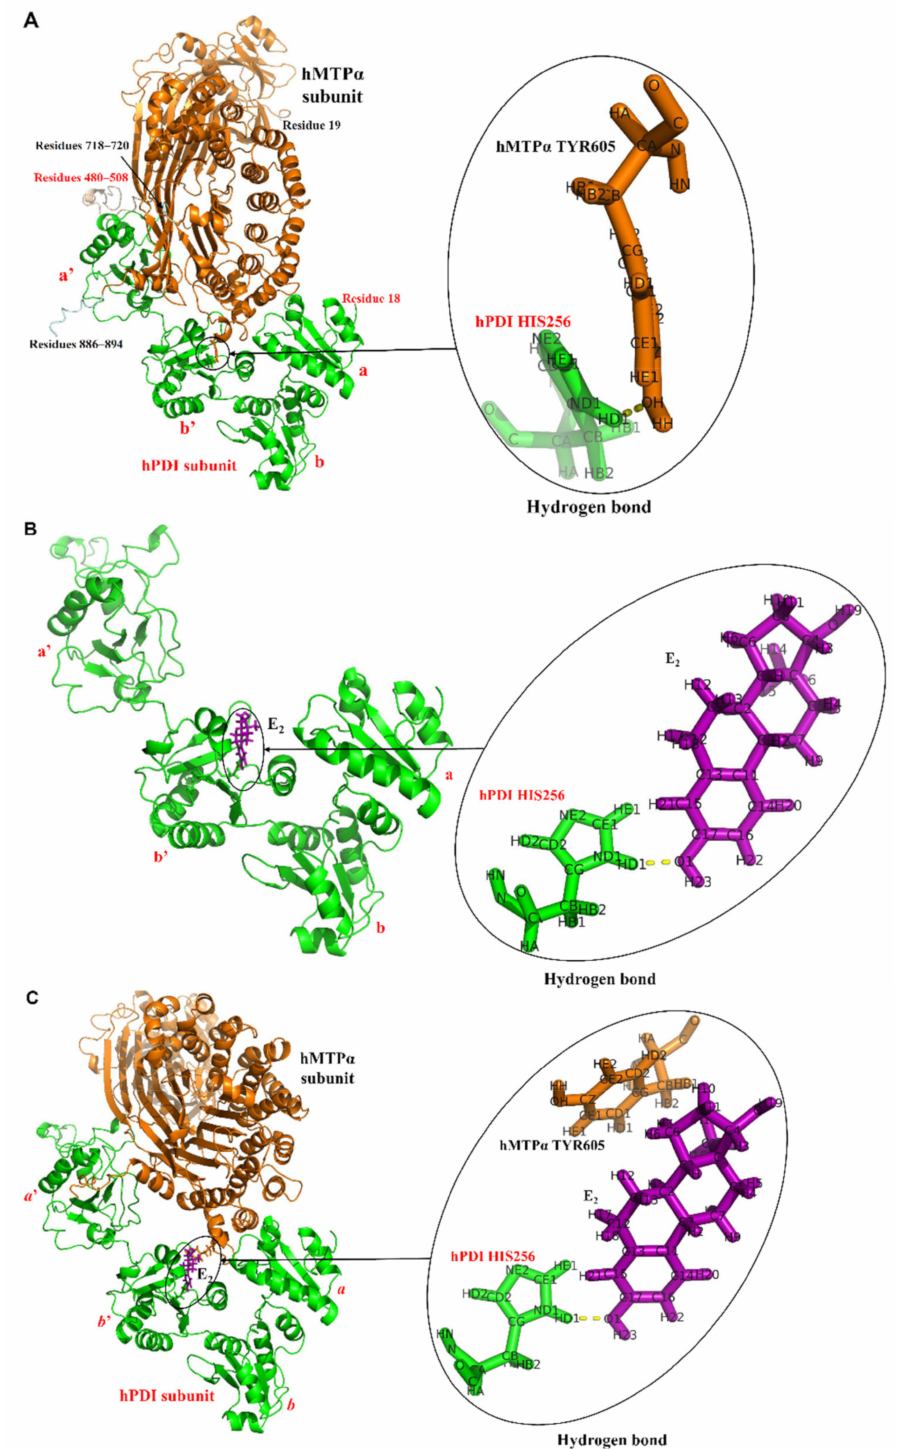
Figure 1. Complete structures of hMTP, hPDI–E 2 and hMTP–E 2 complexes. ( A ) Complete structure of the hMTP complex by adding the missing residues of hMTP α subunit (13 residues) and hPDI (30 residues) back in their experimentally determined structures. There is a hydrogen bond formed between hPDI HIS256 and hMTP α TYR605. ( B ) Structure of the hPDI–E 2 complex predicted using the protein-ligand docking approach. A key hydrogen bond exists between E 2 and hPDI HIS256. ( C ) Structure of the hMTP–E 2 complex constructed using structural alignment. The hMTP α subunit, hPDI and E 2 , are colored in orange, green and purple, respectively. The missing residues in hMTP α subunit and hPDI are colored in wheat and palecyan,